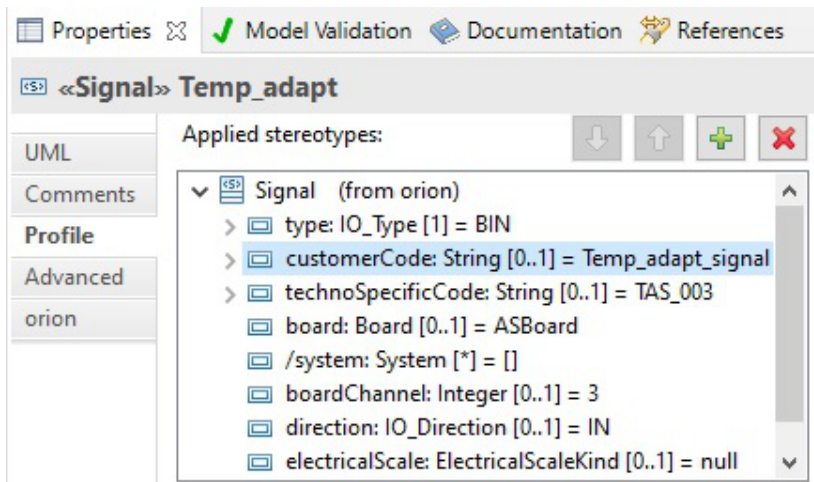
Figure 23. “Temp_adapt” physical signal